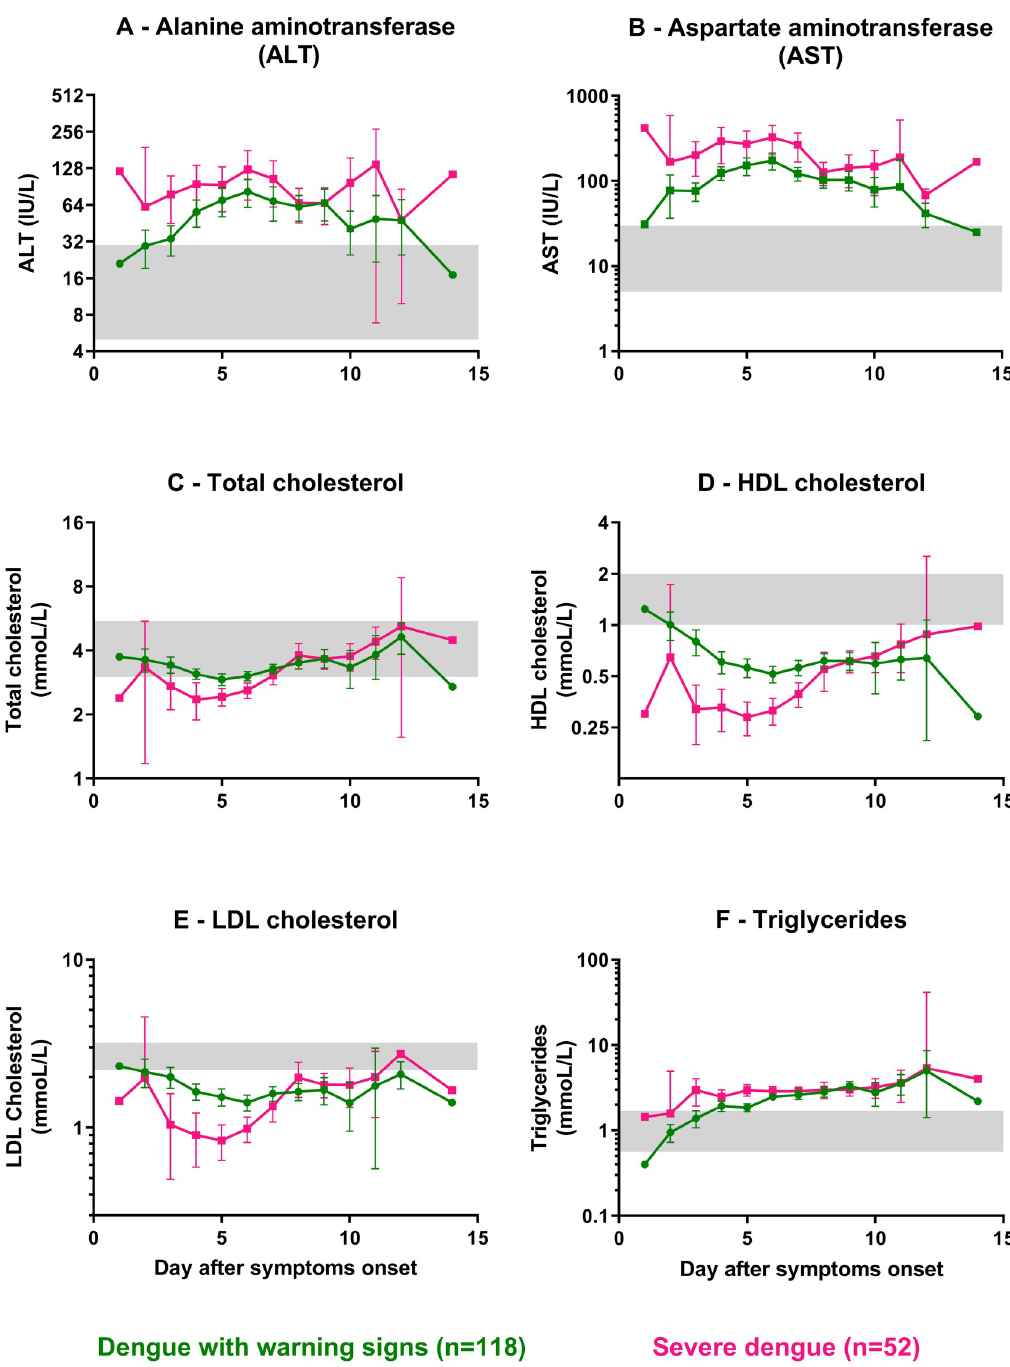
Fig 3. Biochemical parameters observed in hospitalized dengue-infected patients using the adapted WHO 2009 classification scheme. Values at admission, deferverscence and discharge for: dengue with warning signs (DWWS; green circles), severe dengue (SD; pink squares). Liver function : ( A ) Alanine aminotransferase (ALT; IU/L); ( B ) Aspartate aminotransferase (AST; IU/L); Lipid profile : ( C ) Total cholesterol (mmol/L); ( D ) HDL cholesterol (mmol/L); ( E ) Calculated LDL cholesterol (mmol/L); ( F ) Triglycerides (mmol/L). Each circle or square represents the mean of each variable’s observed values per day. Error bars correspond to 95% confidence intervals around the mean. Grey areas represent the normal range for each parameter. Normal ranges used for biochemical parameters were obtained from: https://emedicine.medscape.com/article/ 2172316-overview.